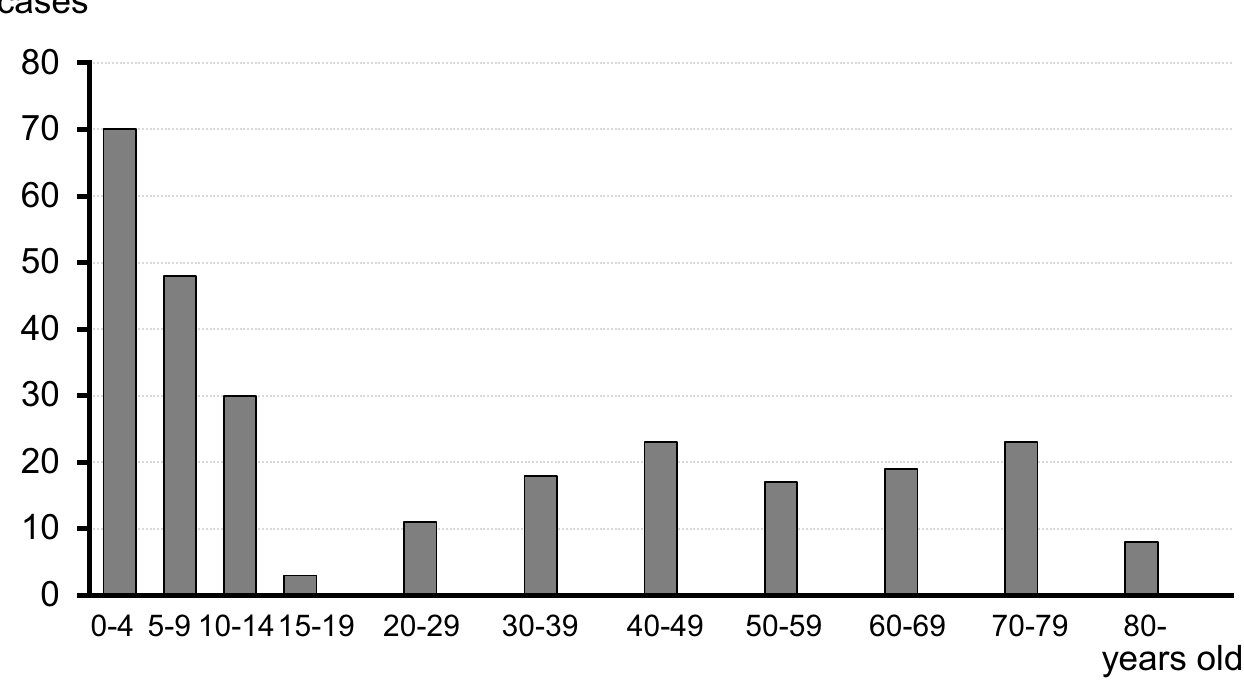
Fig 2. Patients’ age distribution. Patients aged 0–4 years formed the largest group and represented 25.9% of the study population.